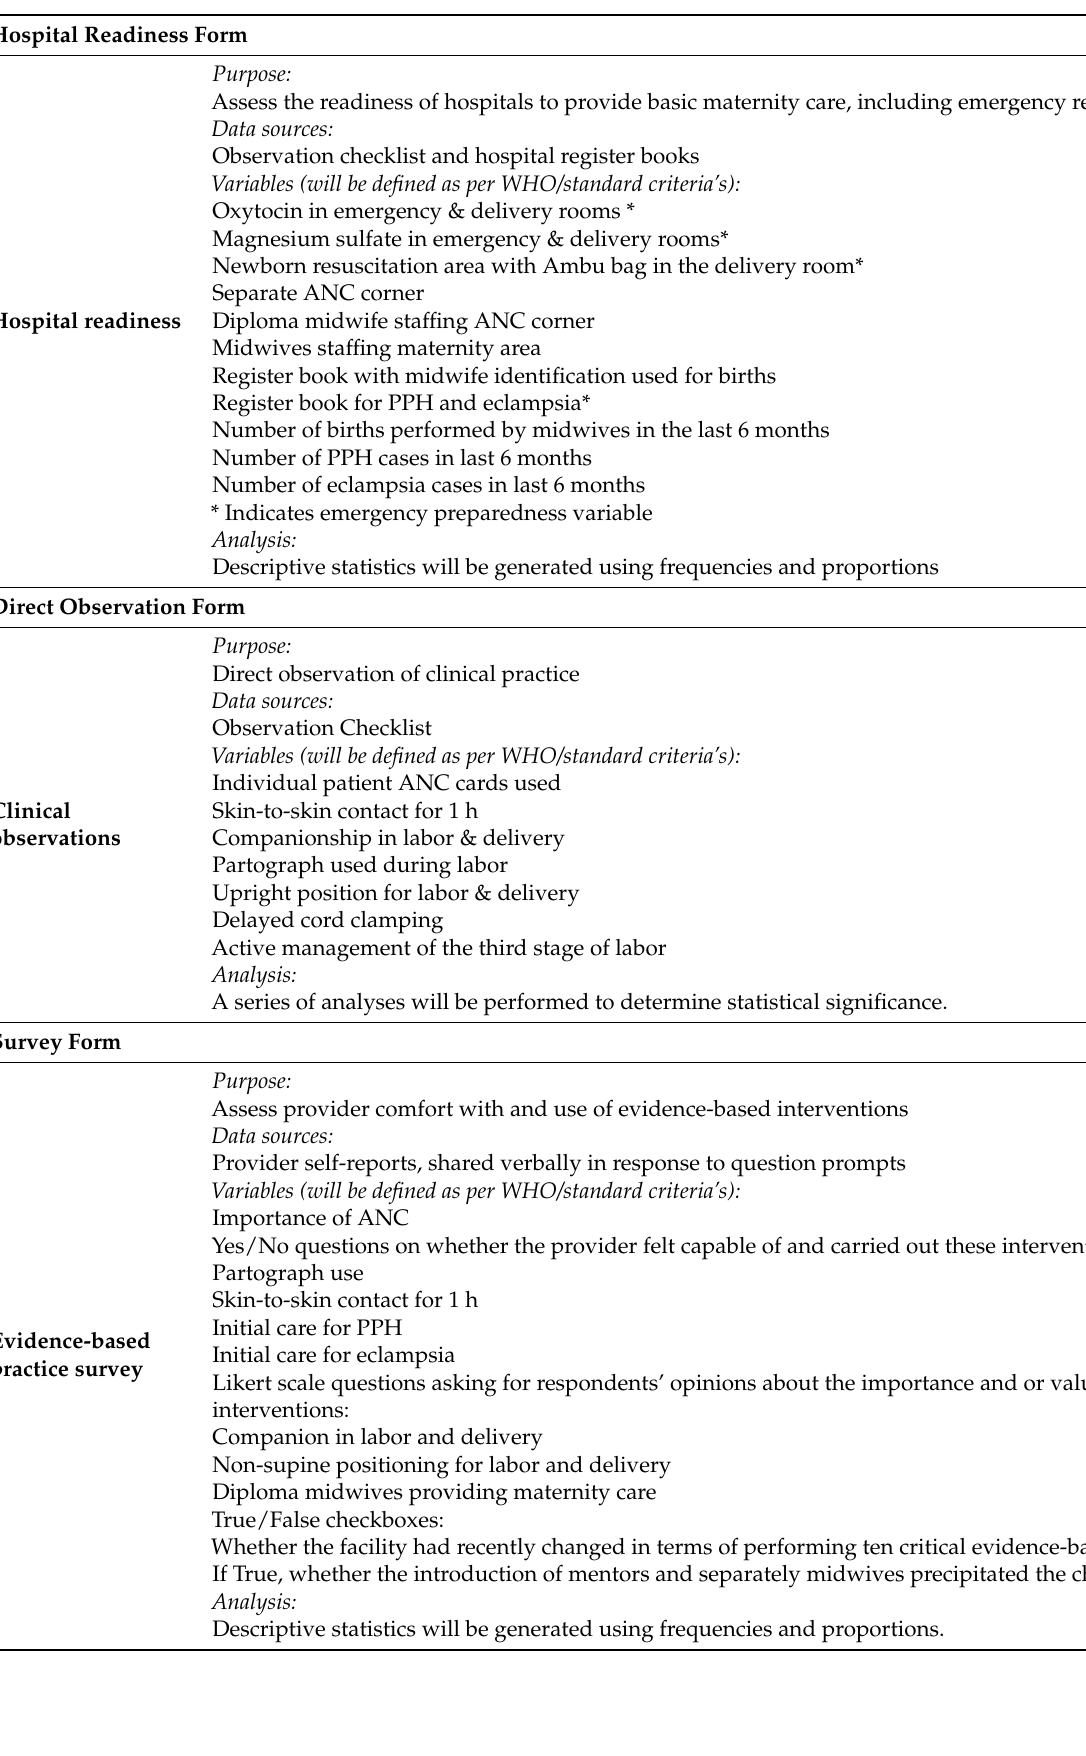
Table 2. Quantitative data collection forms (variables will be defined using a standard definition, as per WHO, to measure the